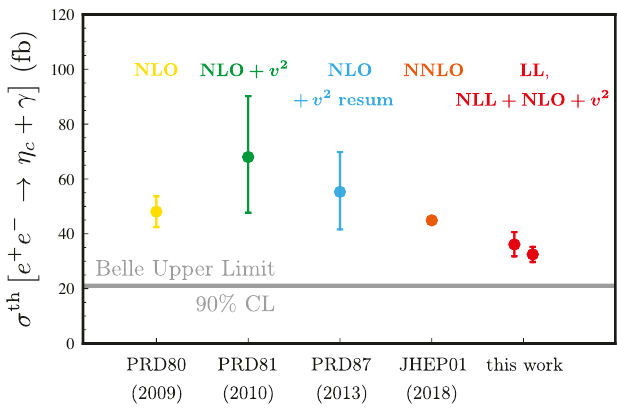
Figure 4 . Status of NRQCD predictions (points) and Belle’s upper limit [30] (horizontal gray line) for e + e (cid:0) ! (cid:17) c + (cid:13) . This work on right side for LL and for NLL+NLO with v 2 corrections is compared to previous predictions (from the left) at NLO [19], NLO with v 2 correction [17] and with v 2 resummation [22], and NNLO [21]. We note that uncertainties of NLO [19] and of NNLO [21] include only quark mass variations while the others include other sources of uncertainties. See the text for more